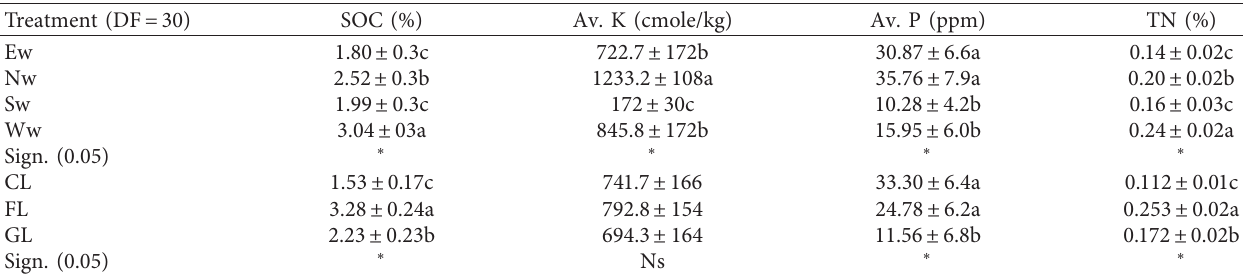
Table 3: The main effect of slope aspect and land use types on SOC and primary macroessential nutrients. Treatment (DF � 30)